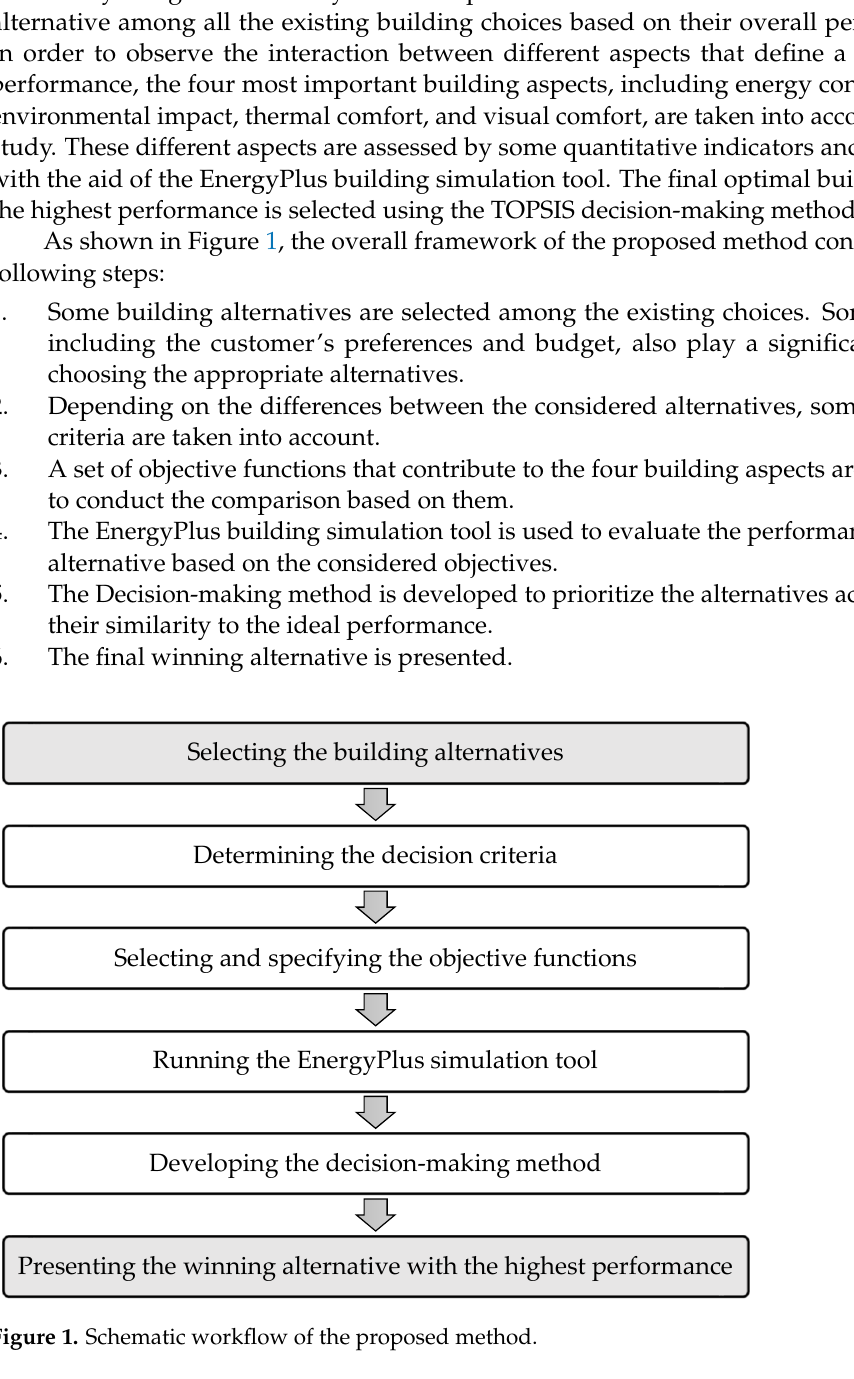
Figure 1. Schematic workflow of the proposed method.